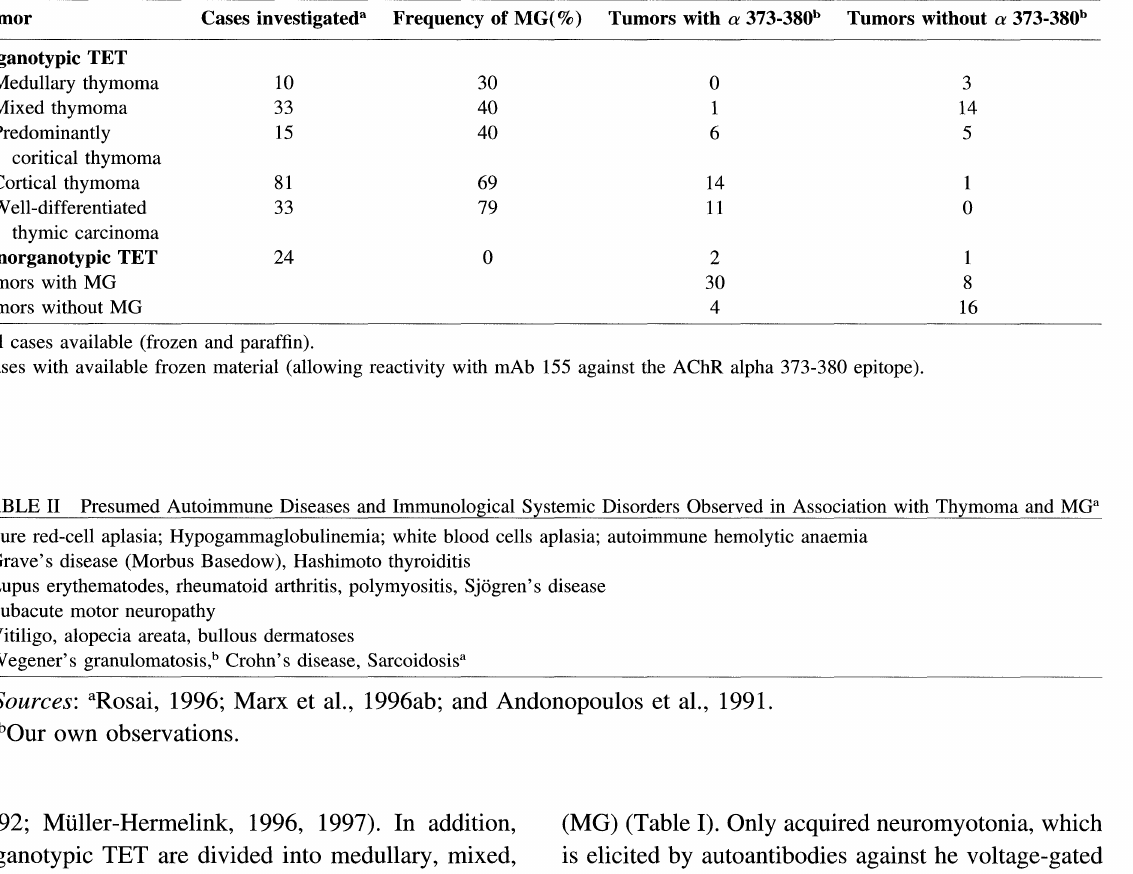
TABLE Frequency of MG and Expression of the AChR Epitope Alpha 373-380 in Thymic Epithelial Tumors (TET) Investigated Between 1970 and 1994 in the Department of Pathology, University of Wtirzburg Tumor Cases investigated Frequency of MG(%) Tumors with a 373-380 b Tumors without a 373-380 b